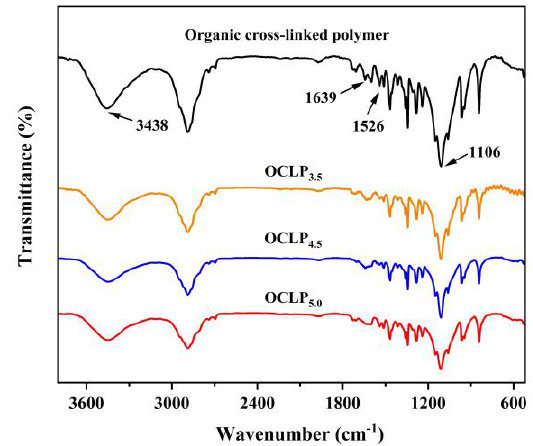
Figure 2. FTIR spectra of the OCLPs and organic crosslinked polymer [27].